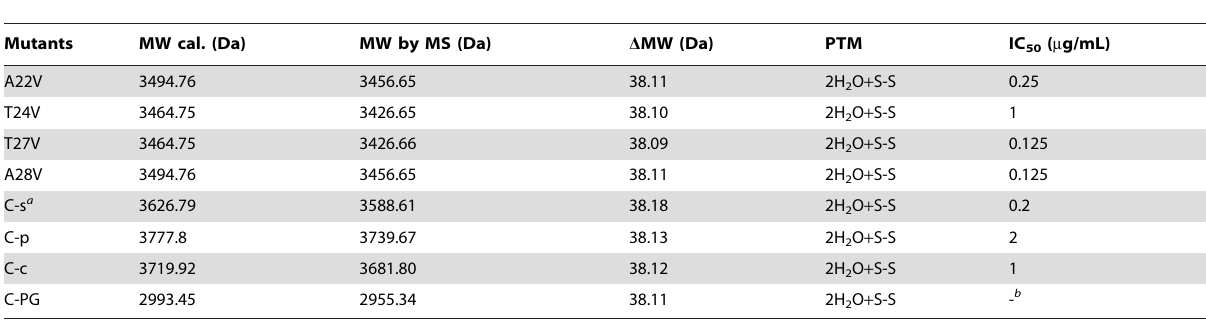
Table 2. MS analysis and IC 50 determination of ring C mutants of bovicin HJ50.